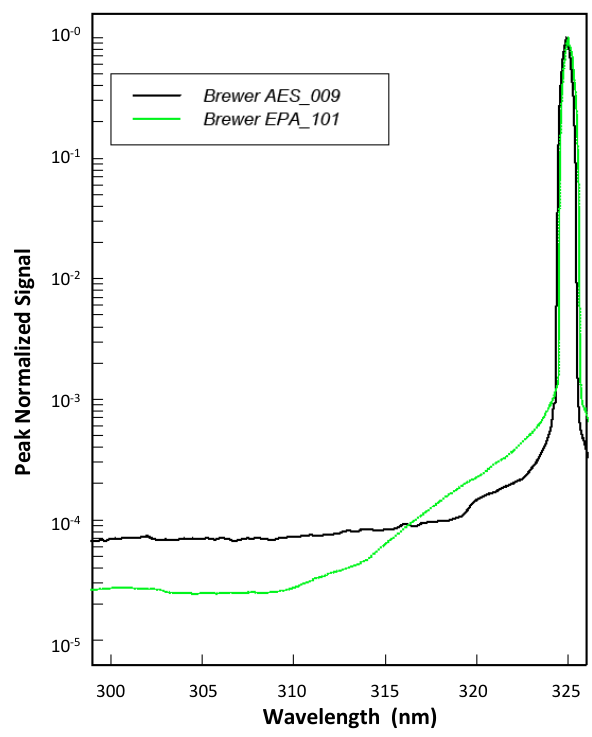
Fig. 4. Slit scattering functions for two Brewers, EC MkII Brewer # 9 (black) and NEUBrew MkIV Brewer #101 (green), measured through slit 1 during 1997 Intercomparison of Ultraviolet Mon- itoring Spectroradiometers (Lantz et al., 2002) (data from: ftp: